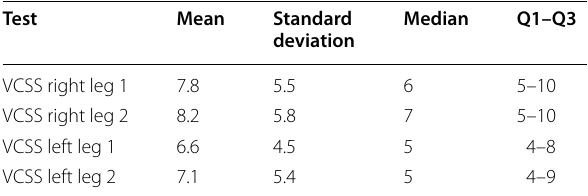
Table 4 Measures of central tendency and dispersion scored during validation of the translated VCSS